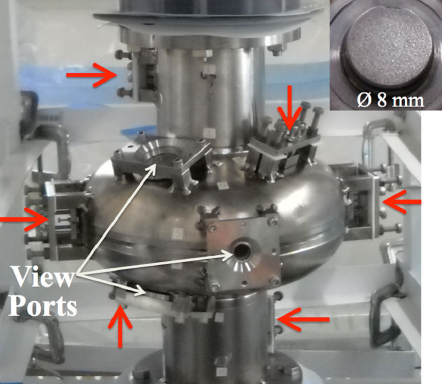
FIG. 1. 1.3-GHz Nb coupon cavity with six disk-type Nb coupons at beam pipe, iris, and equator positions shown by red arrows. Inset: Photograph of a